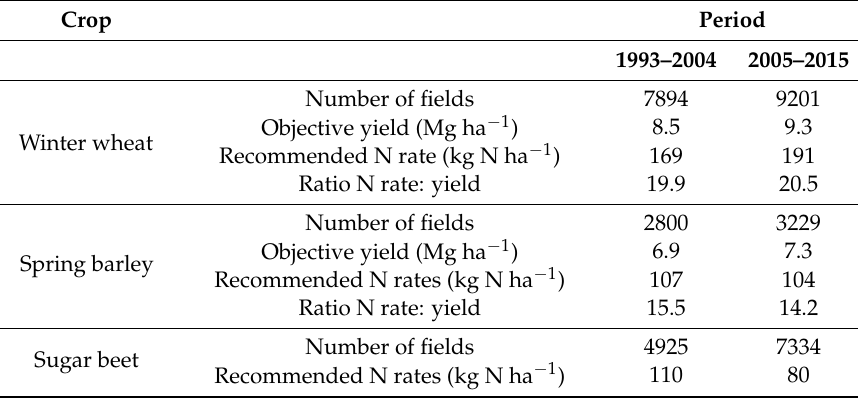
Table 3. Evolution of the N rates recommended by Laboratoire D é partemental d’Analyses et de Recherche (LDAR) for different main crops in northern